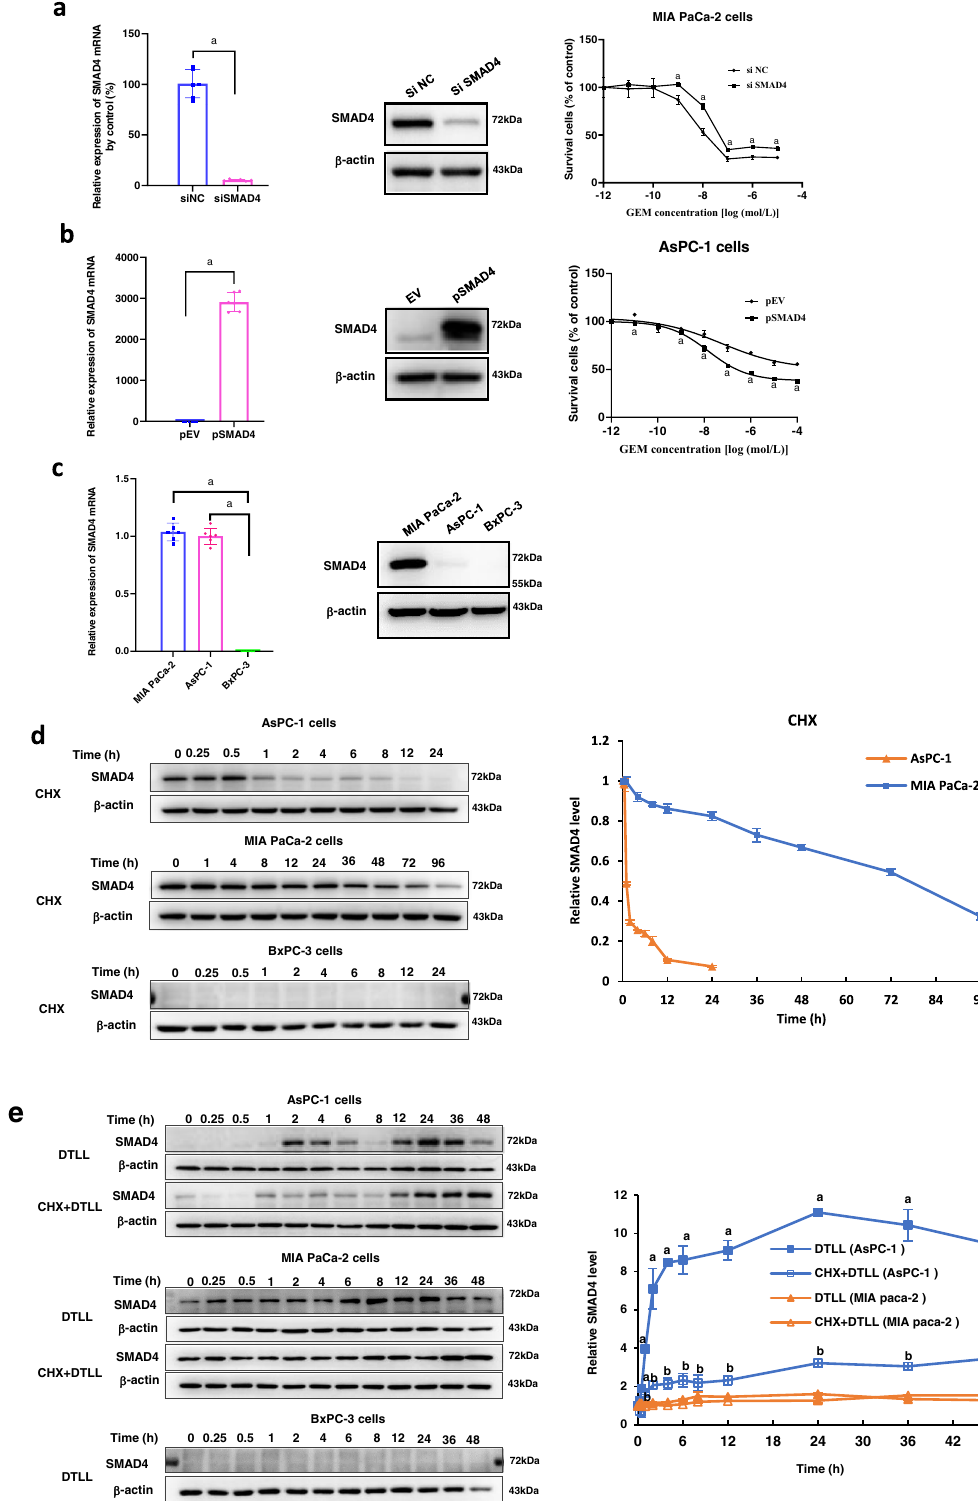
models were sensitive with tumors rapidly developed (https://models. crownbio.com/pancreatic-cancer/). As shown in Supplementary Table 1, the results from the in vivo evaluation of ef fi cacy in PA1233 models indicated thatthe inhibitoryrate of tumor volume on day28 at the end of the experiment was only 11.65% and 31.54% for gemcitabine and DTLL alone, respectively. However, the combination therapy obviously improved the antineoplastic effect with a 72.25% inhibition